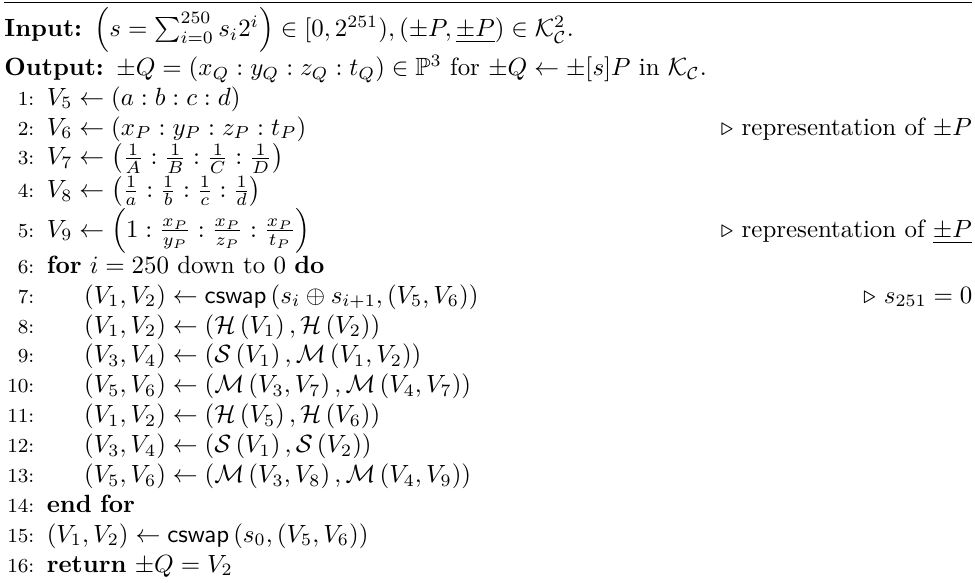
Algorithm 4 mont _ ladder : Montgomery ladder using combined differential double-and-